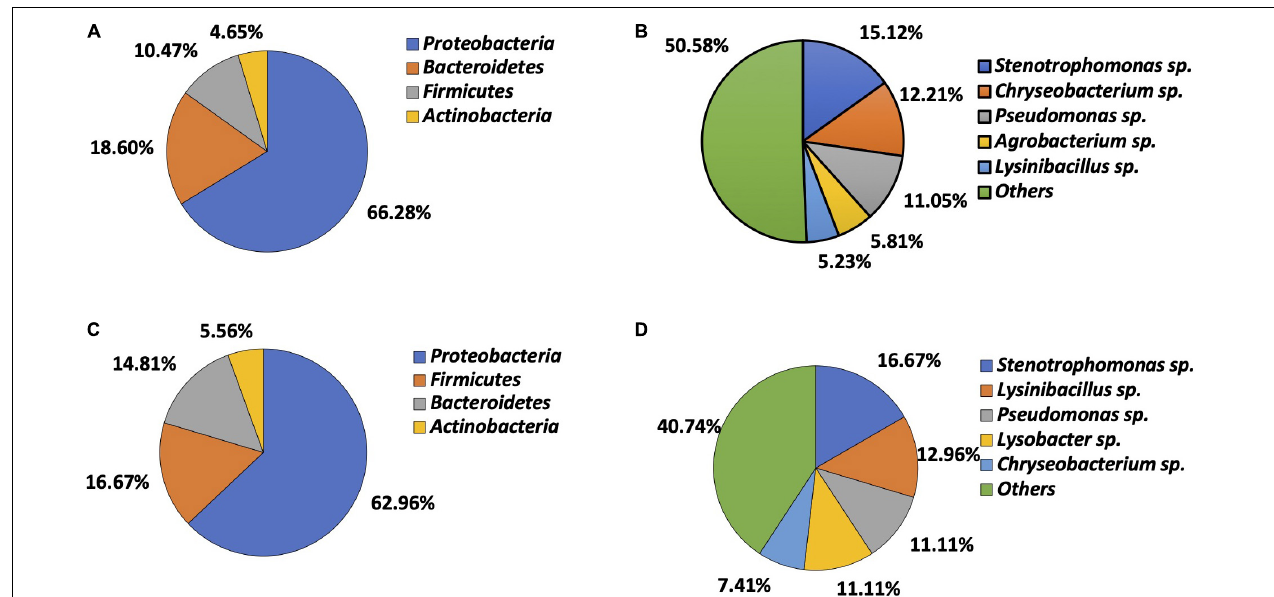
FIGURE 1 | Microbial composition determined by bacteria identification. (A) Phylum distribution in vegetable bacteria ( n = 172). (B) Genus distribution in vegetable bacteria ( n = 172). (C) Phylum distribution in soil bacteria ( n = 54). (D) Genus distribution in soil bacteria ( n = 54).